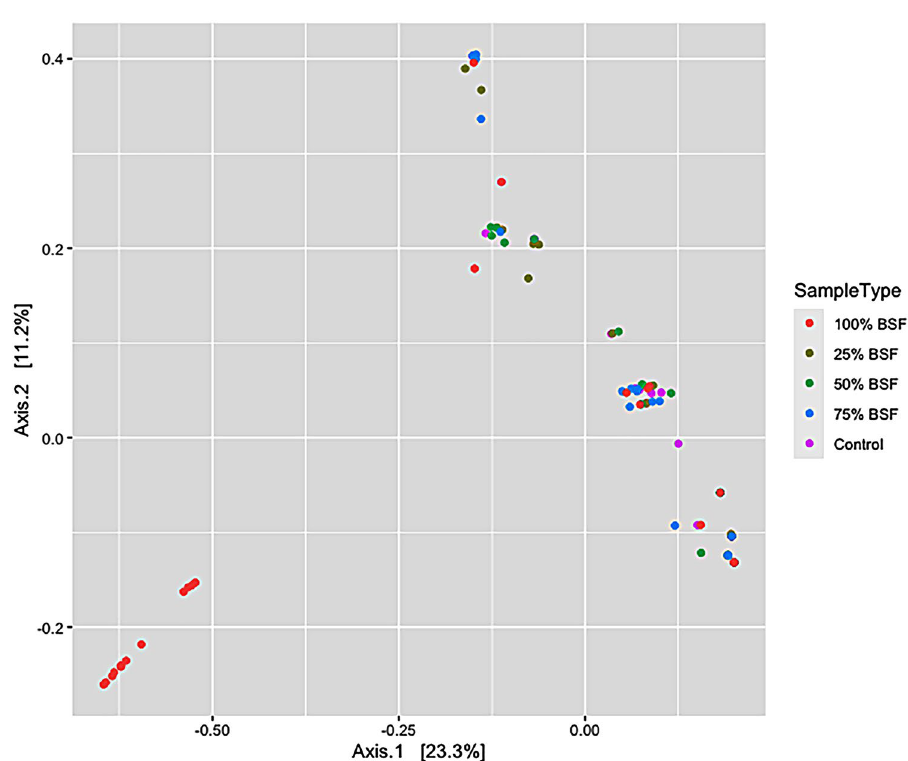
Figure 5. Beta diversity PCoA plot based on unweighted unifrac distance dissimilarity method between the different dietary treatments. [PERMANOVA] R -Squared: 0.11509; p value >